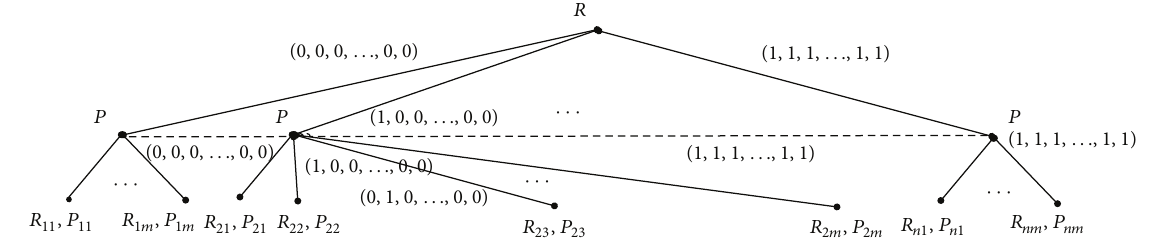
Figure 4: Dynamic game in dealing with information